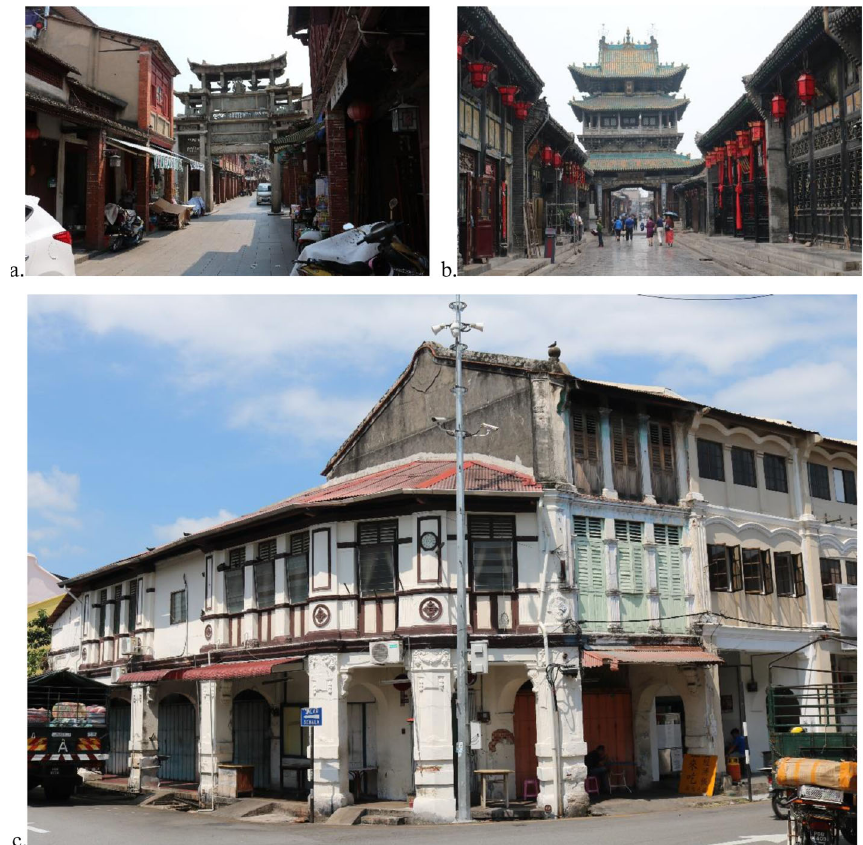
Fig. 1 Historic blocks and their components in the modern era with an adaptive reuse and sustainable development orientation ( a Zhangzhou Old Town 2015; b Pingyao Old Town 2018; c George Town 2019). (Source: The